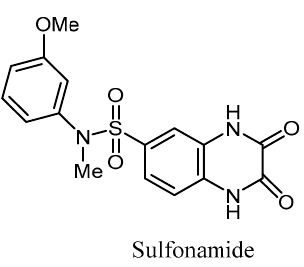
Figure 14. Structure of a sulfonamide as inhibitor of the AAC(2’’).